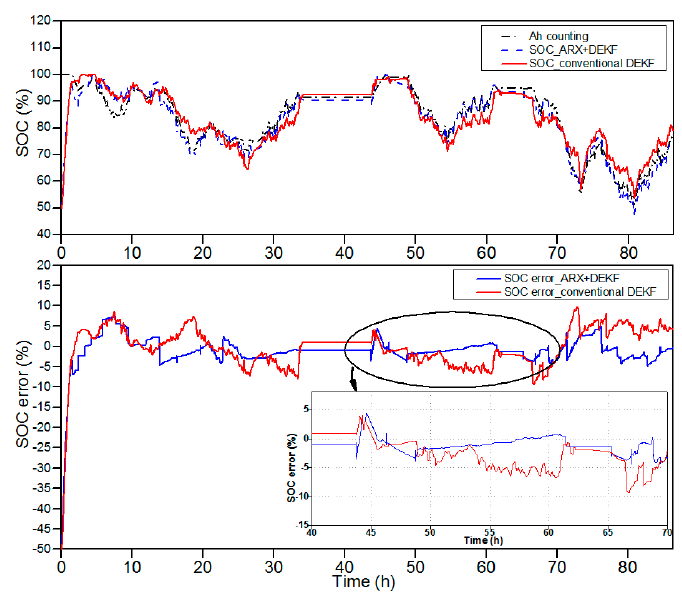
Figure 11. Comparison of the SOC estimation for the aged battery (59.3% SOH) by the proposed ARX+DEKF and conventional DEKF method.